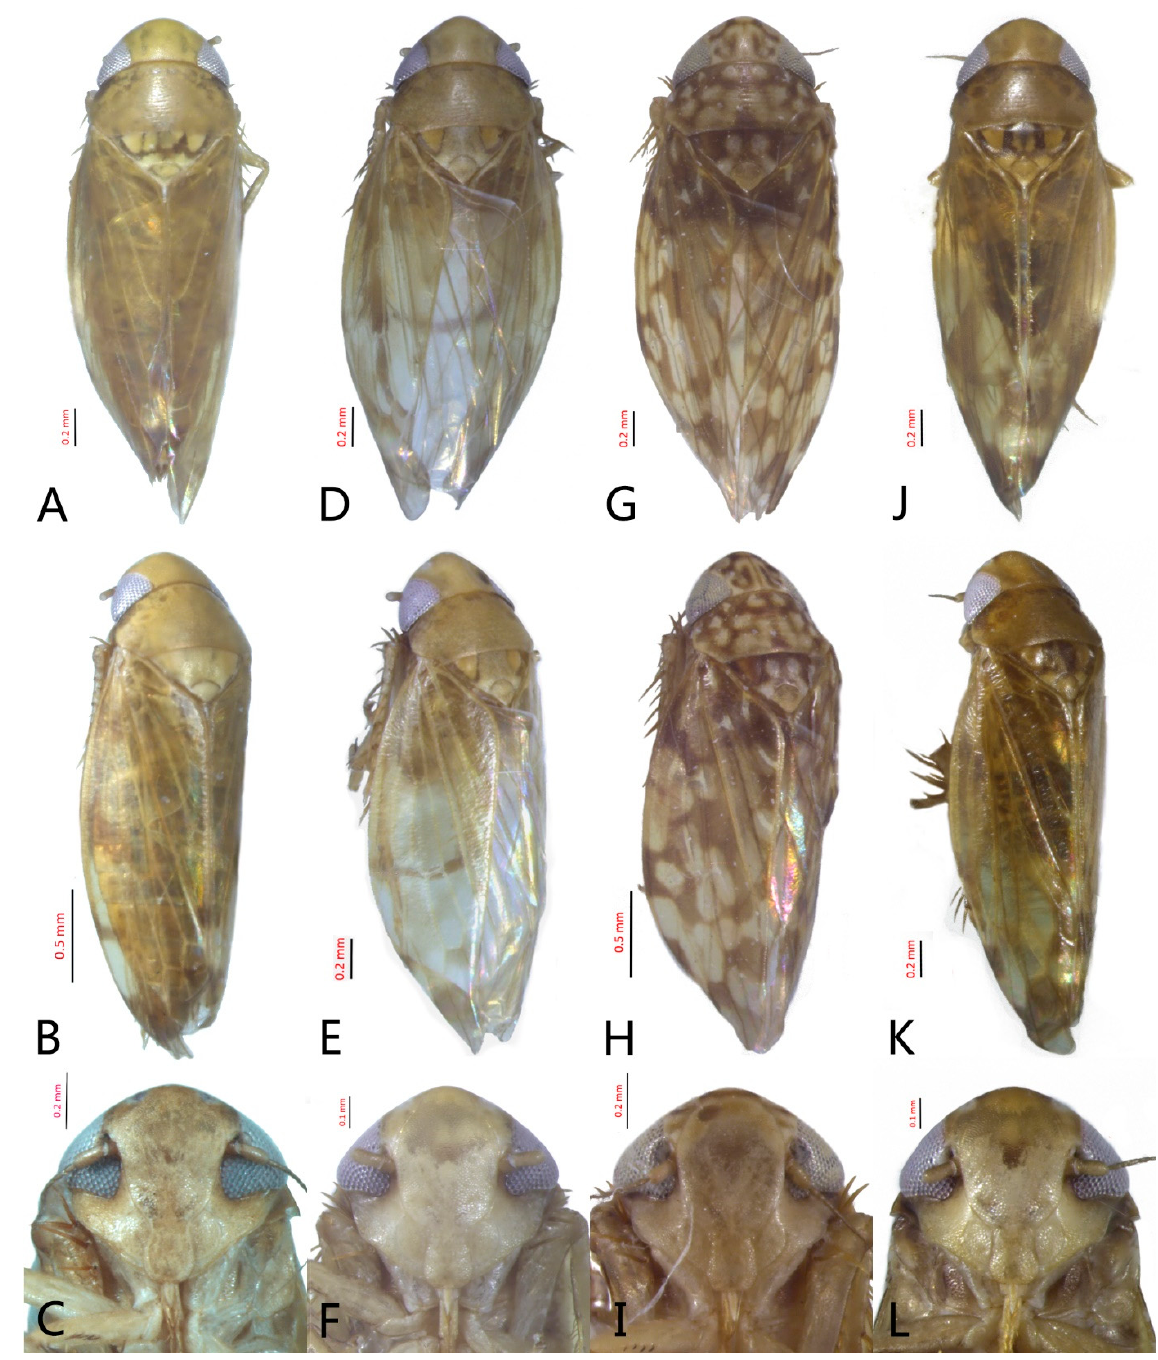
Figure 5. Male habitus of Xestocephalus . ( A – C ) X. gracilus sp. nov.; ( D – L ) X. nonattribus sp. nov. ( A , D , G , J ) dorsal view; ( B , E , H , K ) laterodorsal view; ( C , F , I , L ) face. Male genitalia. Pygofer in lateral view higher than its length, narrowed to round caudal margin, with approximately 8 macrosetae on posterior half; internal process bluntly rectangular and directed ventrad. Valve short and trapezoidal. Subgenital plate broad, linguiform, apex rounded, lateral margins of apical 2/3 slightly curved inwards, with 2 rows of macrosetae. Style slender, S-shaped, with apical dilation of apophysis large thorn-shaped, with numerous scattered marginal and submarginal teeth, tapered to a point, apical 1/2 bent. Aedeagus with dorsal apodeme 1/2 times as long as shaft, shaft